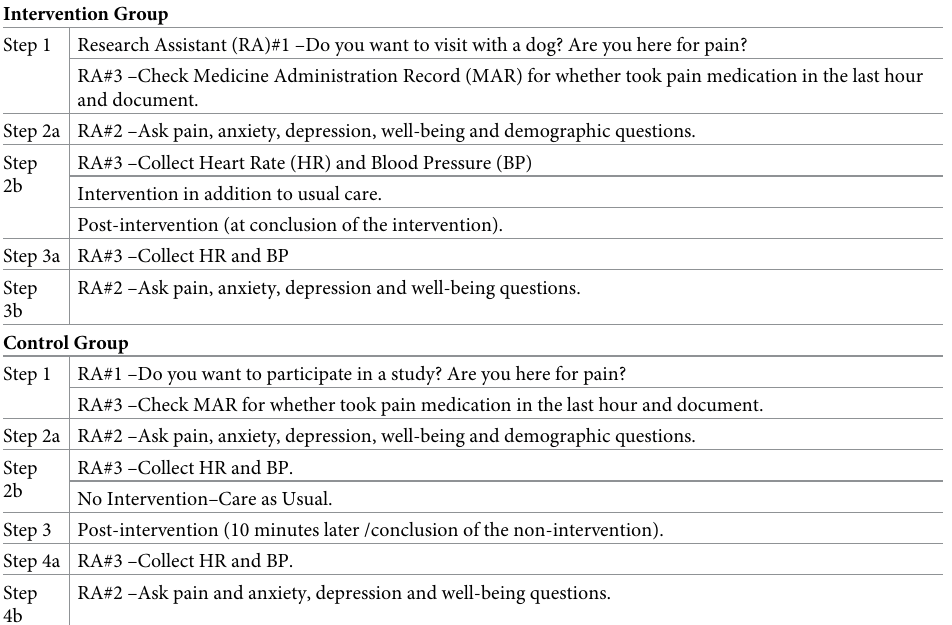
Table 1. Data collection steps for intervention & control